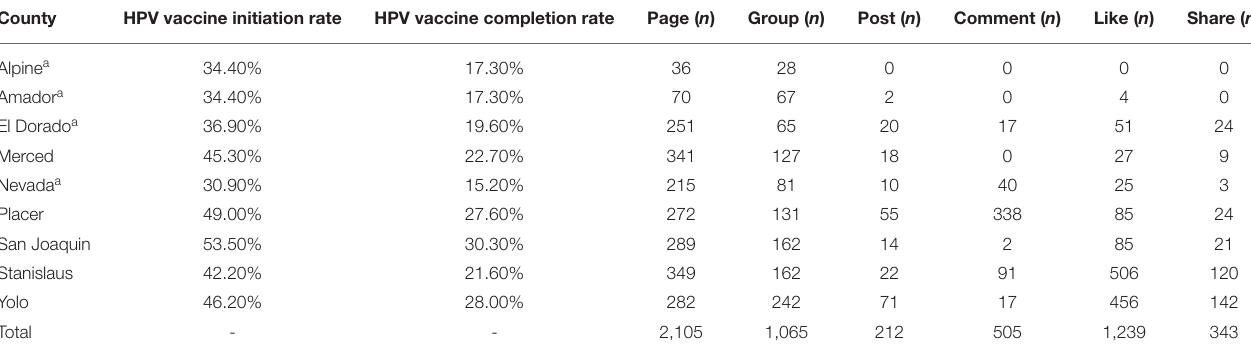
TABLE 1 | Summary statistics on HPV vaccination rates, the number of Facebook pages, groups, posts, and their engagements across the nine counties.